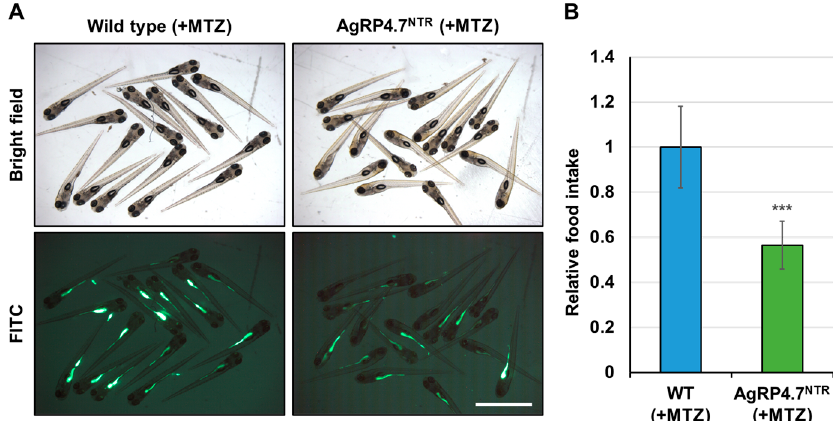
Figure 5. Qualitative food intake assay for MTZ-treated WT and AgRP4.7 NTR larvae. ( A ) Side views of 8 dpf larvae were observed under fluorescence lighting. MTZ-treated WT and AgRP4.7 NTR larvae were cultivated with 4-Di-10-ASP-labeled paramecia for 1 h before observing the fluorescent contents in their guts. Scale bar: 2 mm. ( B ) Relationship between the relative amount of paramecia and fluorescence intensities of ingested paramecia in zebrafish. All values are represented as the mean ± SEM, n = 50. *** p < 0.001.